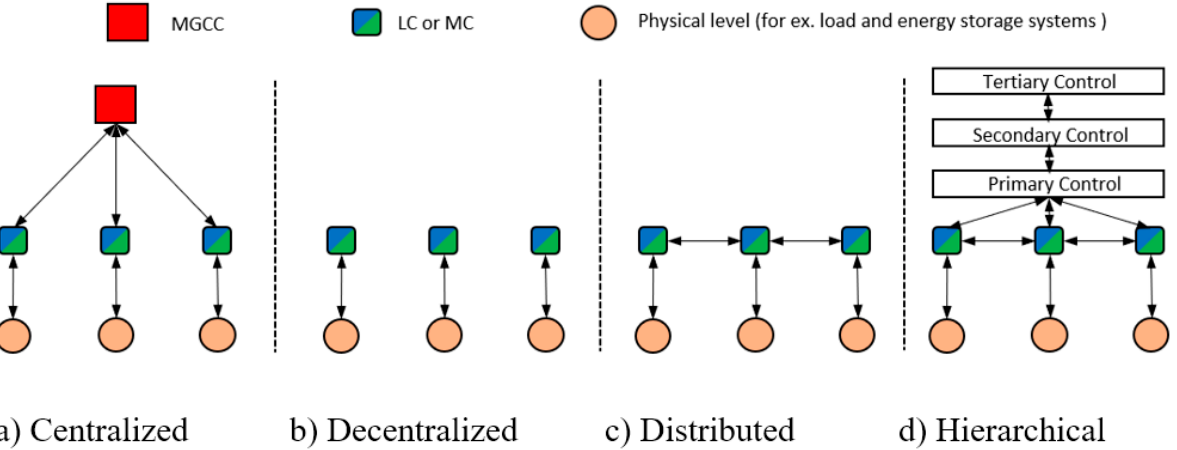
Figure 4. Microgrid structure and control components with example ESSs: ( a ) Centralized, ( b ) Decentralized, ( c ) Distributed, and ( d ) Hierarchical.